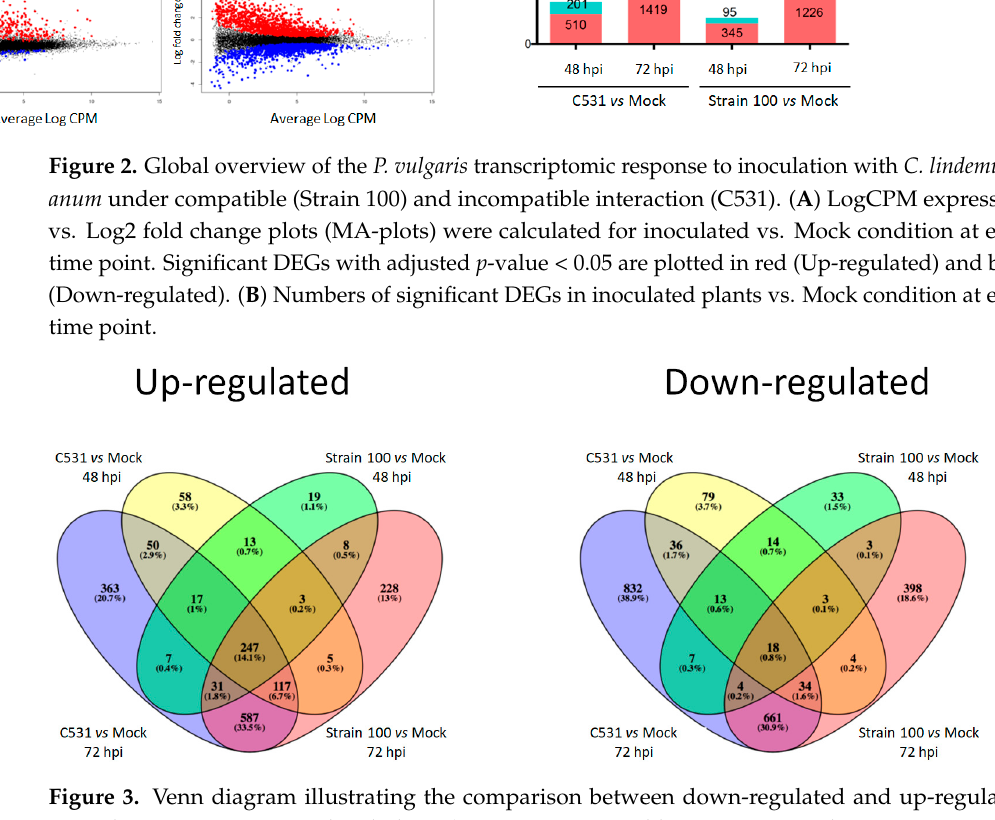
Figure 2. Global overview of the P. vulgaris transcriptomic response to inoculation with C. lindemu- thianum under compatible (Strain 100) and incompatible interaction (C531). ( A ) LogCPM expression vs. Log2 fold change plots (MA-plots) were calculated for inoculated vs. Mock condition at each time point. Significant DEGs with adjusted p -value < 0.05 are plotted in red (Up-regulated) and blue (Down-regulated). ( B ) Numbers of significant DEGs in inoculated plants vs. Mock condition at each time point.